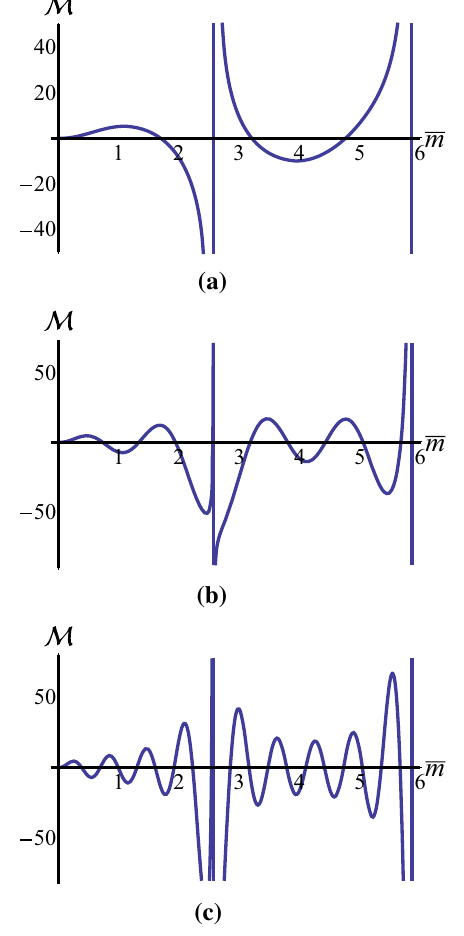
Fig. 2 The effect of the size of the extra dimension, ¯ z b (large ¯ z b > 1), on the mass spectra of the scalar KK modes. The other parameters are set to k = − 3 and λ =